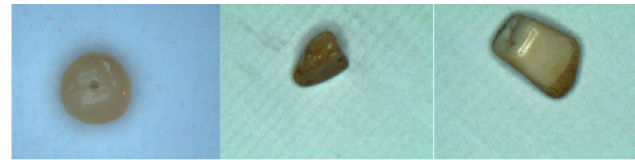
Figure 3. Images of amber gemstones before processing.